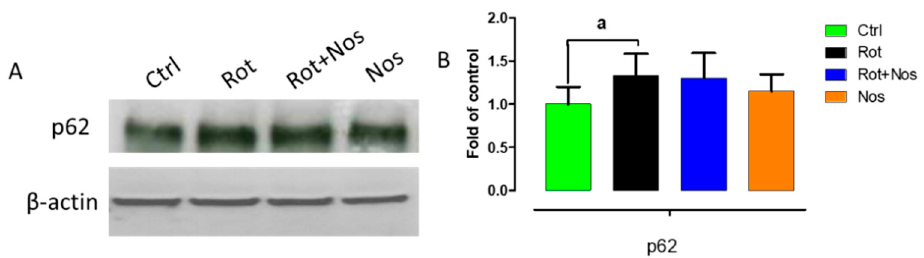
Figure 7. Noscapine prevented dopaminergic degeneration through regulating autophagy. Im- munoblotting of midbrain samples ( n = 5) with p62 ( A ). Quantitative analysis of immunoblotting of p62 ( B ). Values are represented as mean ± SEM. a p < 0.05 compared to control.